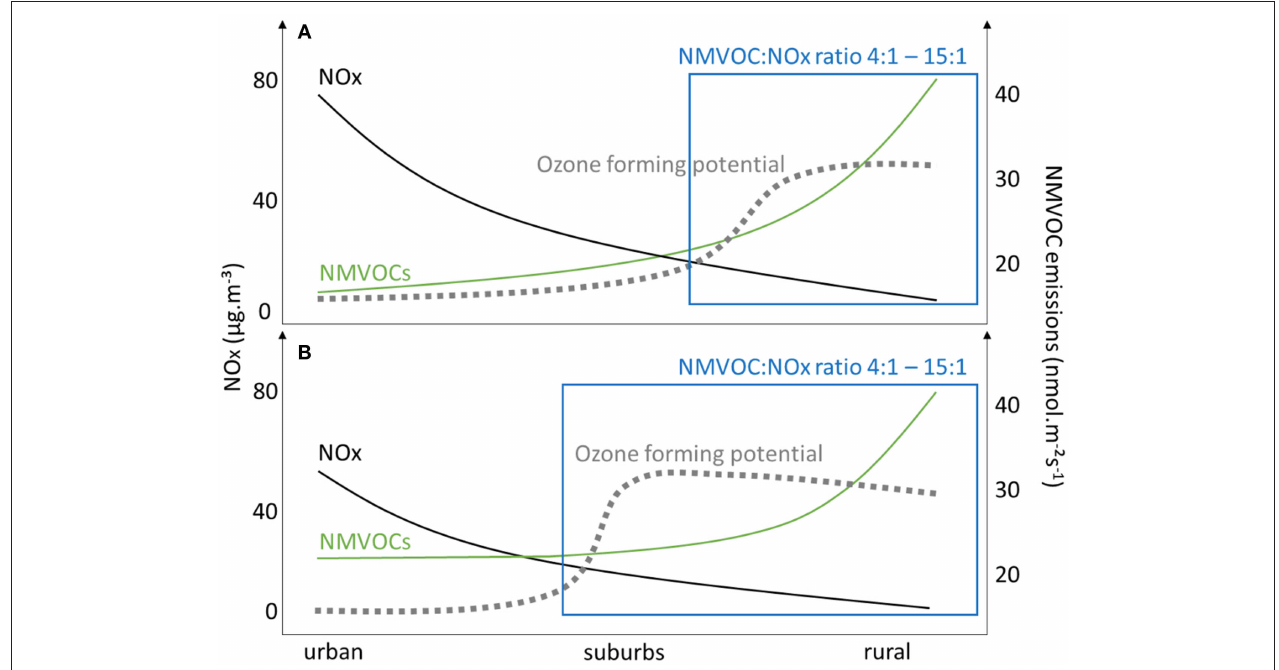
FIGURE 4 | A schematic display of current NO x -VOC-O 3 relations (approximated from literature values) (A) , and a possible future scenario after decreasing NO x pollution (black solid line) and increased non-methane hydrocarbons (NMVOCs, green solid line) in cities due to greening (B) . A left shift of the ozone forming potential curve (gray dotted line) indicates higher ozone pollution in suburbs, since the NMVOC:NO x ratio reaches optimal values to form ozone (blue